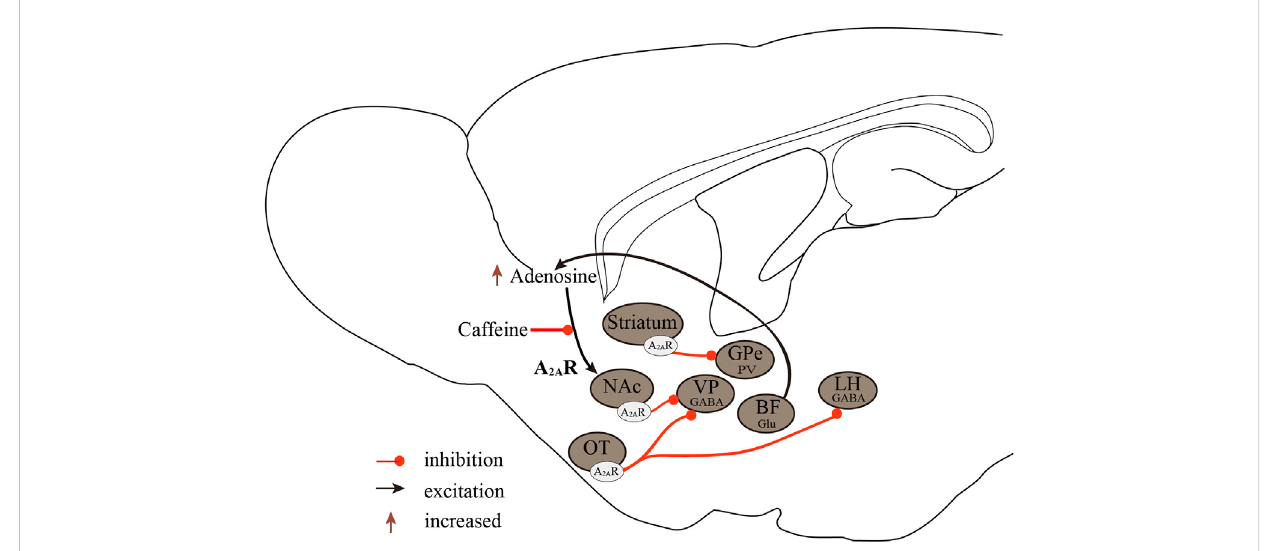
FIGURE 2 Neurobiological mechanisms of theA 2A Rsregulatesleep-wakestates. A 2A Rsareimportant targetsin sleepregulation,promotingsleep byinhibiting majorarousalsystems.ActivationofA 2A RneuronsintheNAccore,striatum,andOTpromotessleep,withA 2A RsneuronsintheNAccoreprojectingtothe VP, striatal A 2A R neurons, and GPe PV neurons forming inhibitory circuits, and OT A 2A R neurons projecting to the VP and LH. Furthermore, BF glutamatergic neurons may regulate extracellular adenosine levels, and A 2A Rs rather than A 1 Rs mediate the wake-promoting effects of